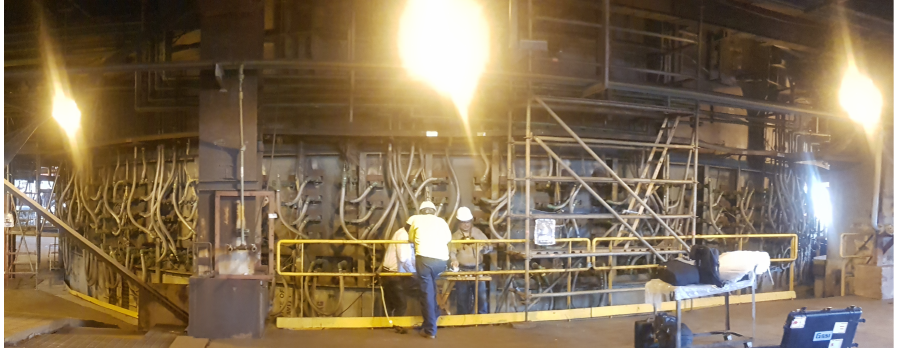
Figure 1. Steps in the Ferronickel extraction process.